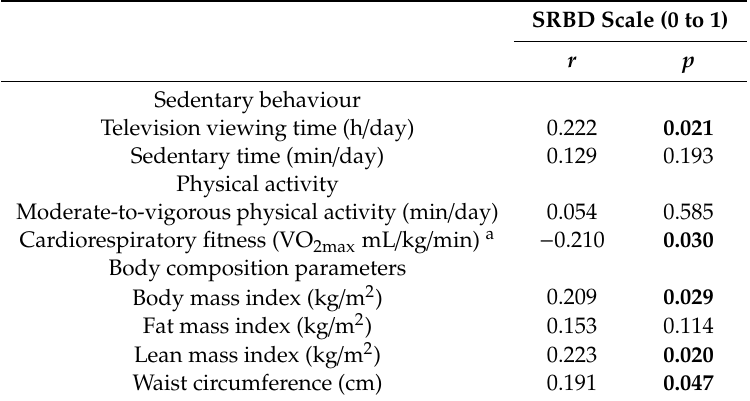
Table 2. Pearson’sbivariatecorrelationcoefficientsofsedentarybehaviour,physicalactivity,cardiorespiratory fitness, and body composition parameters with sleep-related breathing disorders scale.